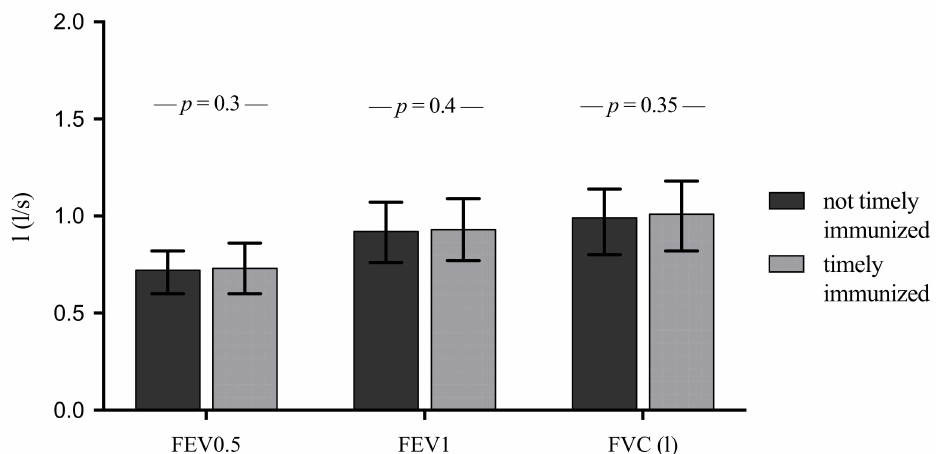
Figure 3. Spirometry at 5-year follow-up. FEV0.5/1, forced expiratory volume in 0.5/1 s/s; FVC, forced vital capacity; p -values were derived from Pearson’s Chi-square test; n = 1117